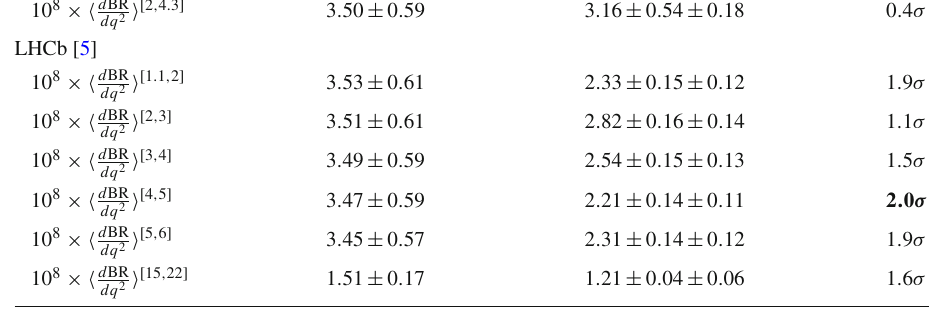
branching ratio of B + → K ∗+ μ + μ − included in the global fit